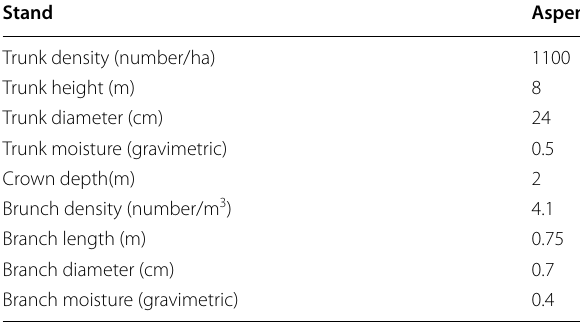
Table 1 Model inputs in the MIMICS model Stand Aspen